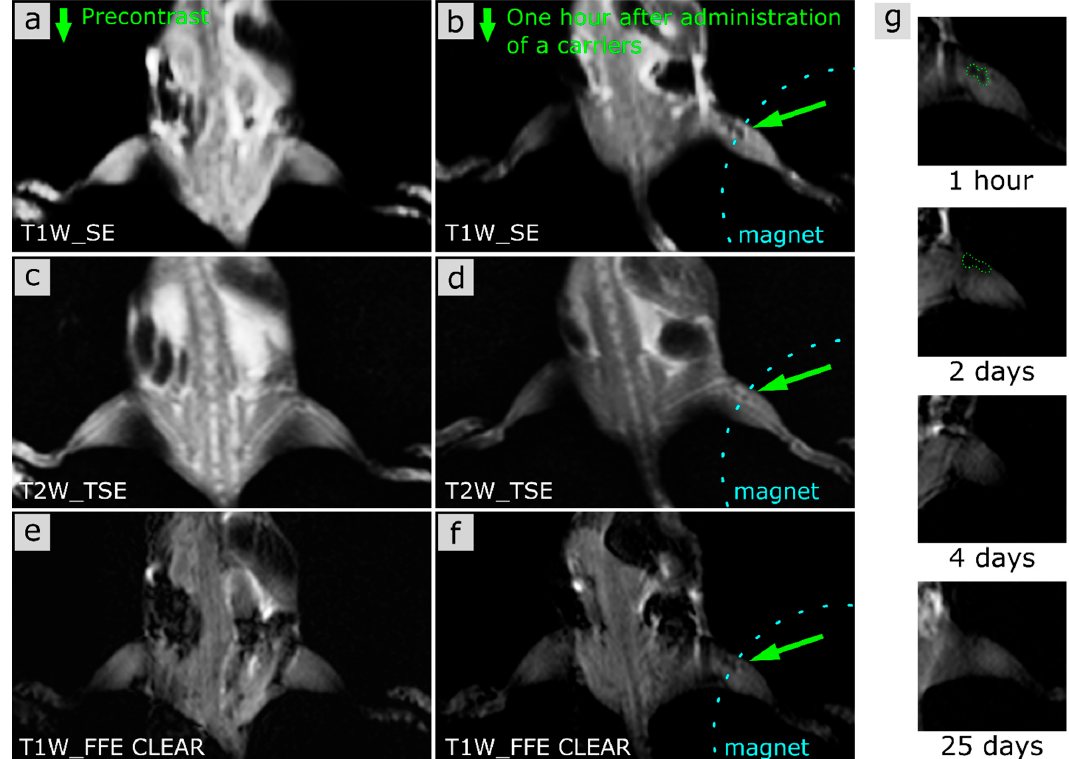
Figure 3. MR T1 and T2 images of the mouse. ( b , d , f )—1 h after intravenous injection of a microcarrier suspension; ( a , c , e )—control mouse without any injections. The dotted blue line shows the area of magnet application, ( g )–T1W_FFE CLEAR images of paw 1 h, 2, 4, and 25 days after intravenous injection of a microcarrier suspension.